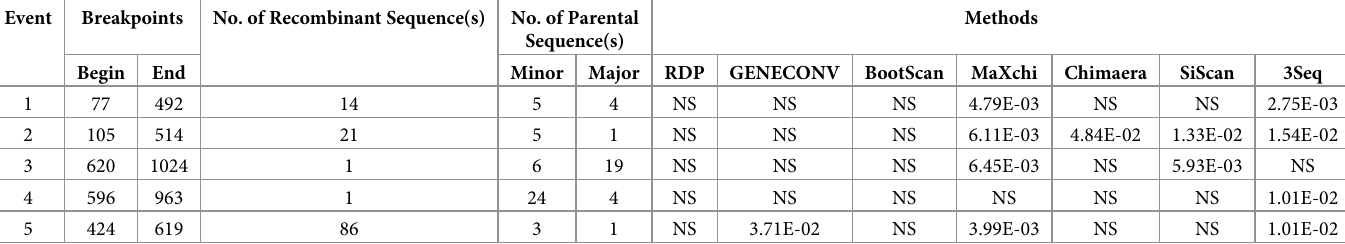
Table 3. Crossover sites in pvrbp2b sequences by using recombination detection methods in RDP v.4.101